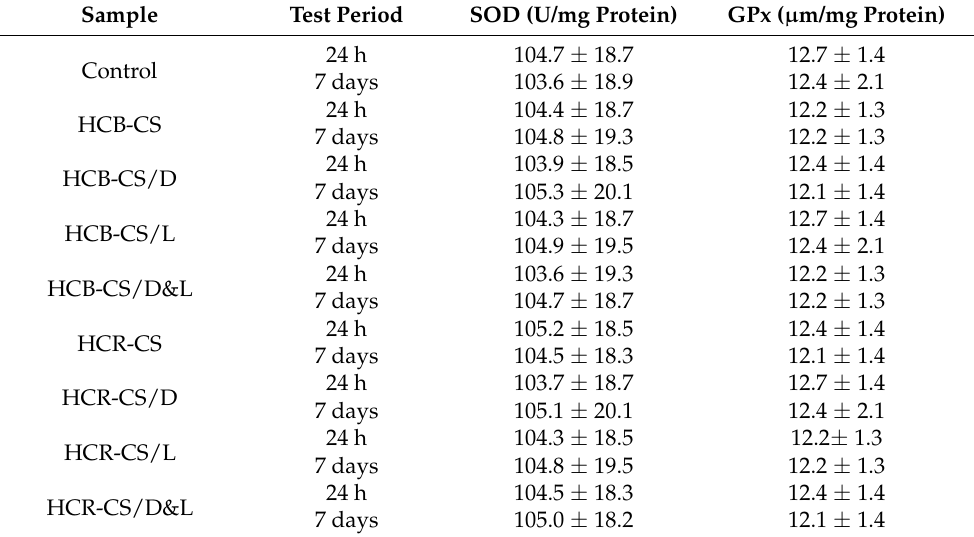
Table 8. Changes in the values of superoxide dismutase (SOD) and glutathione peroxidase (GPx) in the blood of animals that received electrospun samples. Values are expressed as arithmetic mean ± SD of the mean SOD and GPx values for 5 mice per batch.